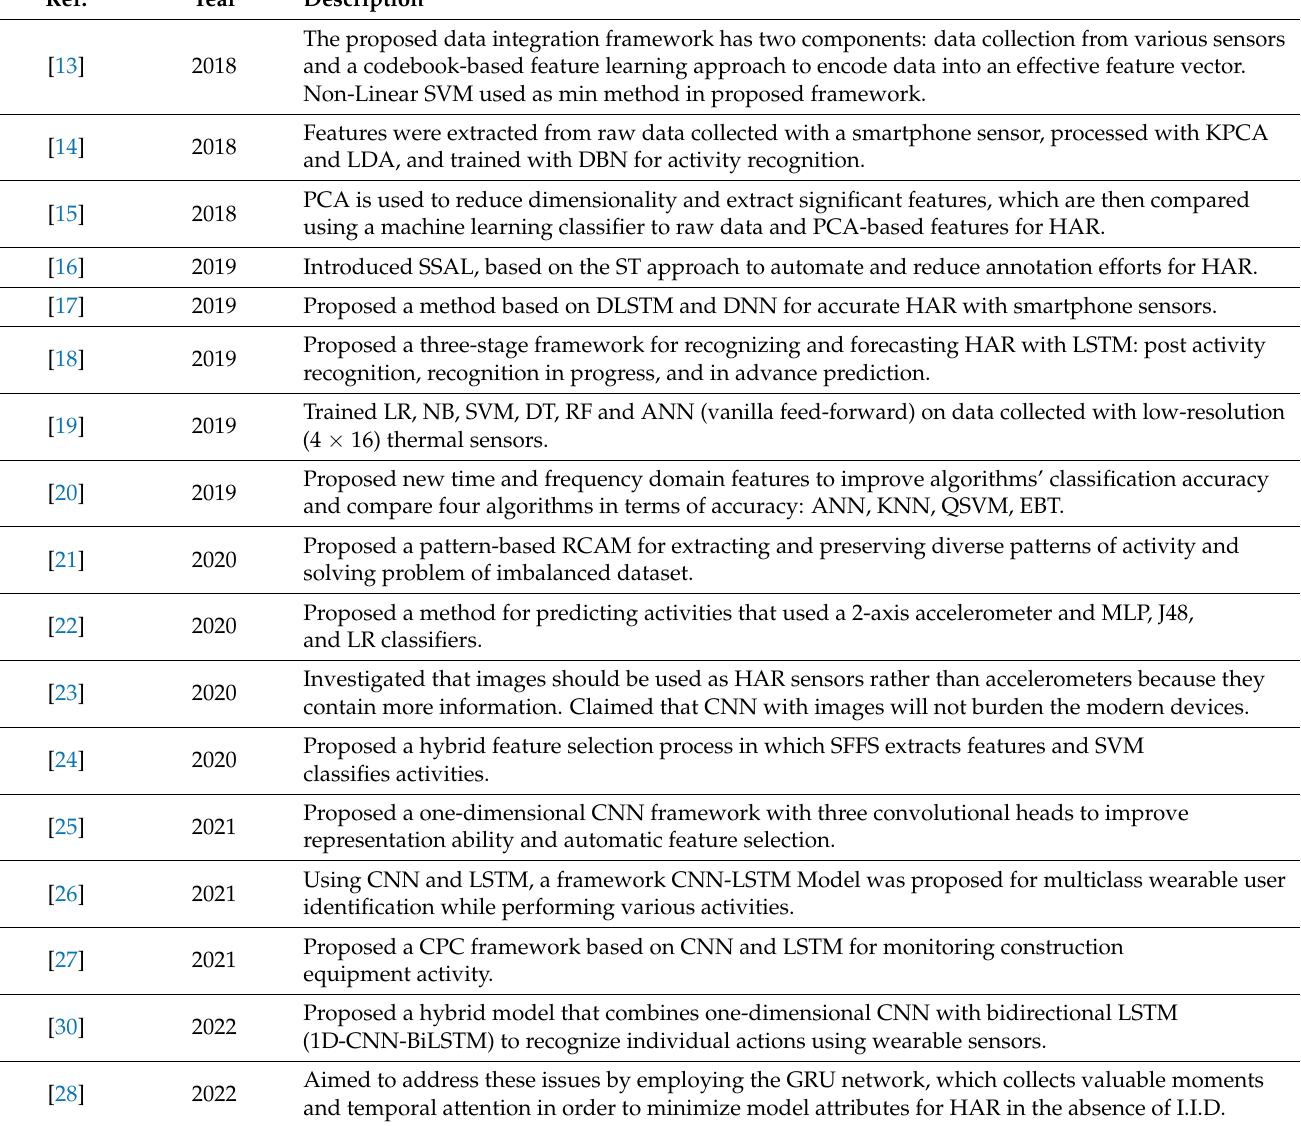
Table 1. Summary of literature on static